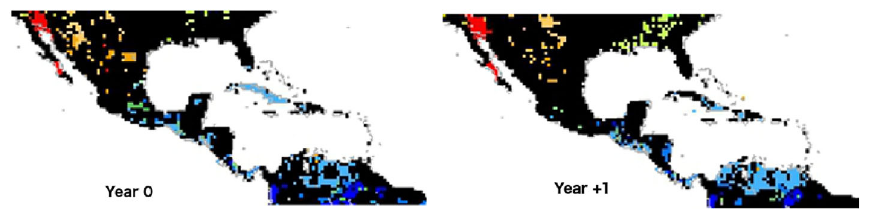
Fig. 2 Ko¨ppen–Geiger variability from a 60-year average (1951–2010) for El Nin˜o Year 0 (left) and Year ? 1 (right) based on five strong El Nin˜os in the Central American and circum-